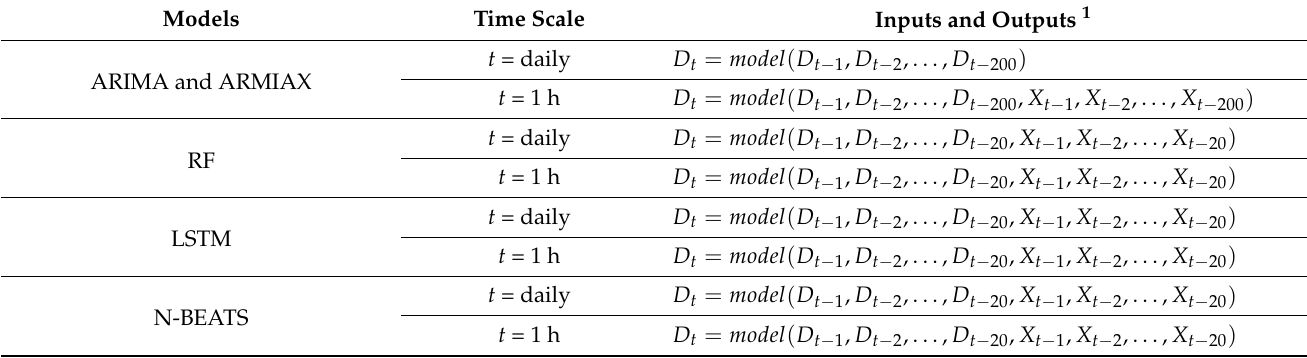
Figure 4. Hourly bath water demand (BWD) by ( a – c ) weekday and ( d – f ) gender. Table 2. Inputs of modes for daily and hourly time